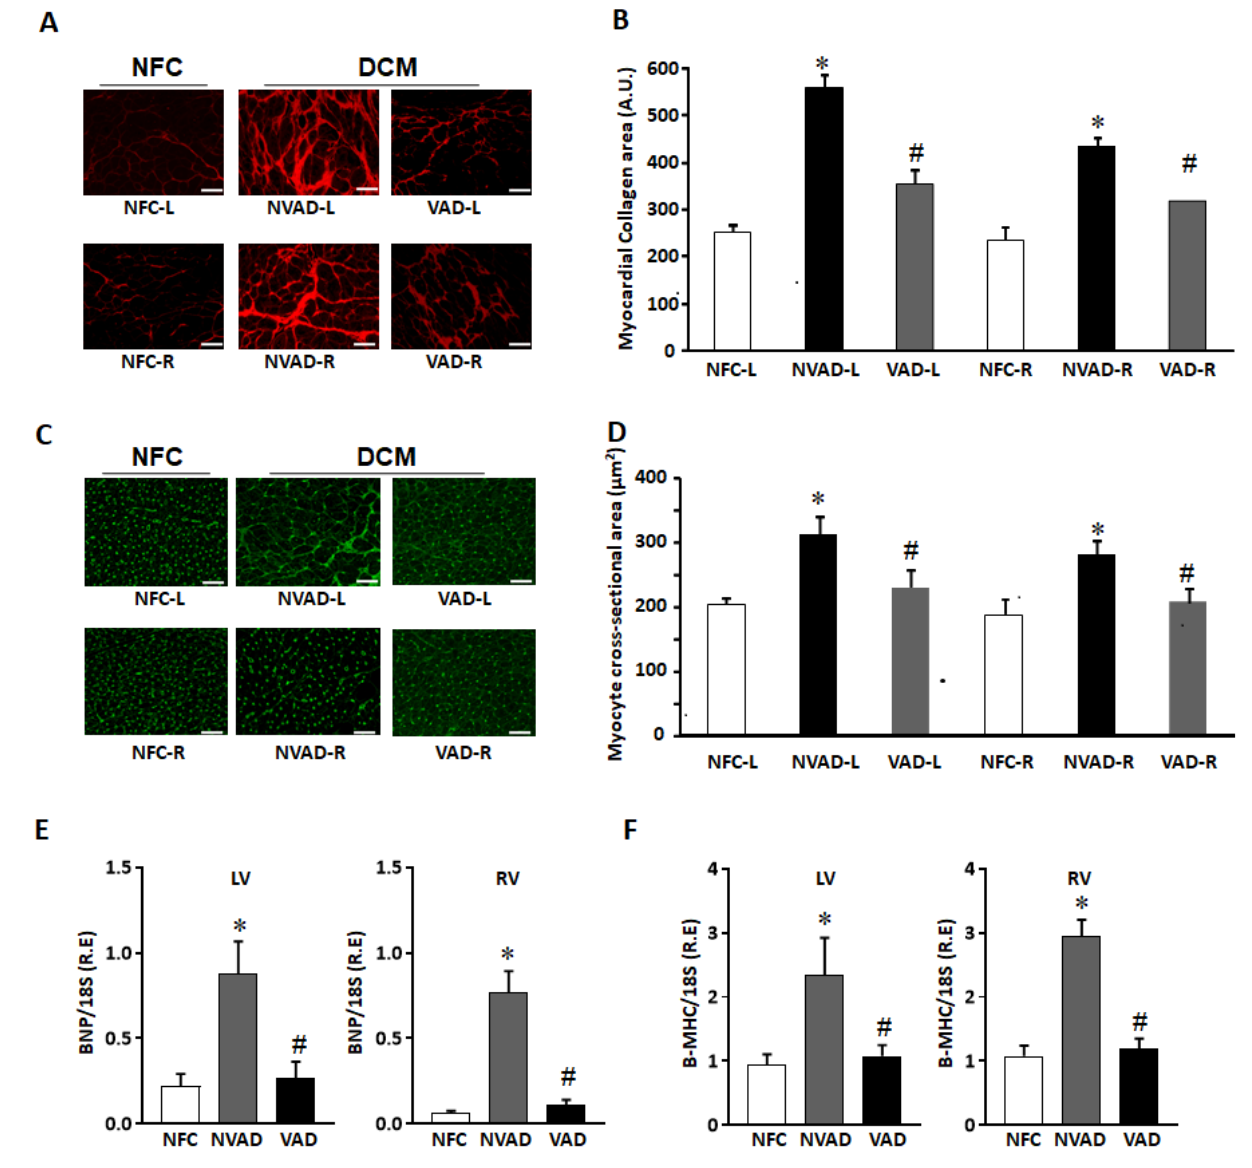
Figure 1. Histological characterization of non-failing control (NFC) and dilated cardiomyopathy (DCM) hearts. ( A ) Representative Picrosirius red staining images for collagen detection in NFC hearts, as well as DCM hearts with left ventricle assist device (VAD) and without LVAD support (NVAD). ( B ) Myocardial collagen content quantified from ( A ). ( C ) Representative Wheat germ agglutinin staining for NFC, DCM-VAD and DCM-NVAD hearts. ( D ) Cardiomyocyte cross-sectional area (CCA) quantified from ( C ). ( E , F ) Real-time quantitative PCR results showing the relative mRNA levels of hypertrophic markers brain natriuretic peptide (BNP) and β -myosin heavy chain ( β -MHC) in NFC, NVAD, or VAD. n = 8, * p < 0.05 vs. NFC, # p < 0.05 vs. NVAD, unpaired two-tailed t-test. L, left; R, right. Scale bar represents 50 μm.